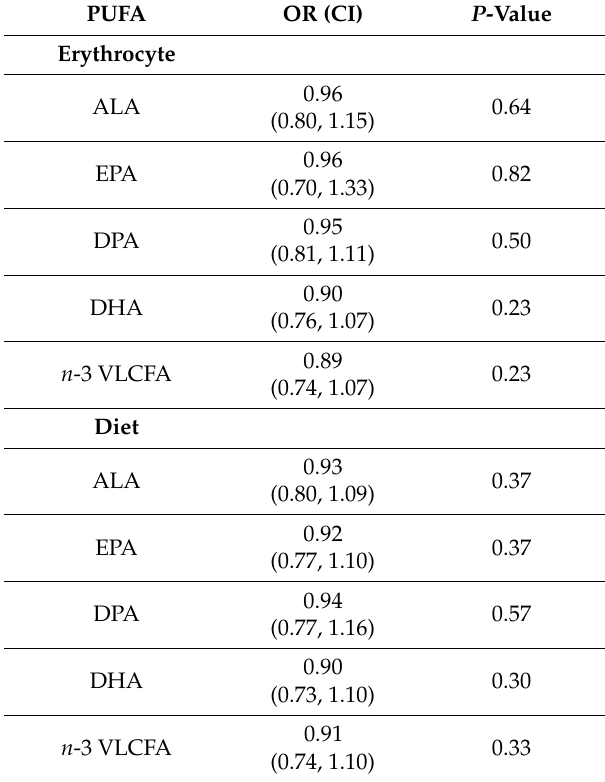
Table 4. Association between baseline erythrocyte n -3 PUFA composition (z-score) and risk of 2-year cognitive impairment among those considered to not have cognitive impairment at baseline ( n = 688) a,b,c . PUFA OR (CI) P -Value